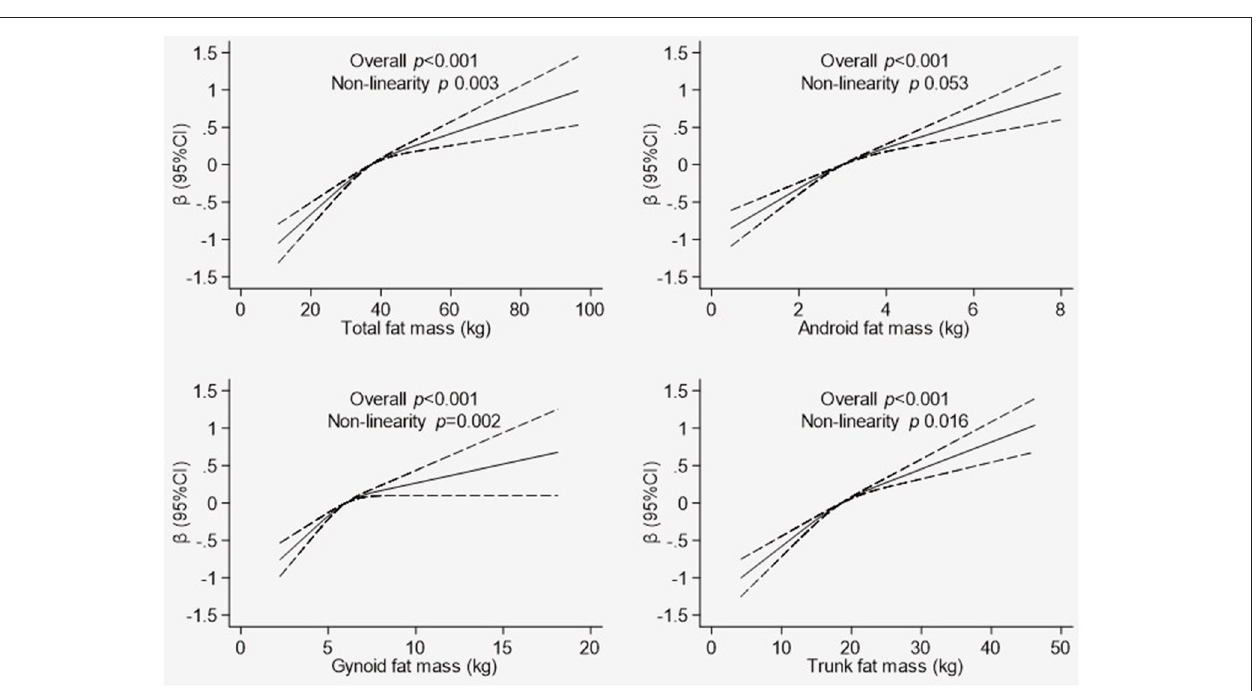
FIGURE 1 | Association between whole body Tscore and body composition indicators. Graphical representation of non-linear association between total fat mass, android fat mass, gynoid fat mass, and trunk fat mass with T-score of total BMD derived using the restricted cubic spline method. The models were adjusted for are age, physical activity, supplement use, and smoking status. Dotted line represents the 95% confidence